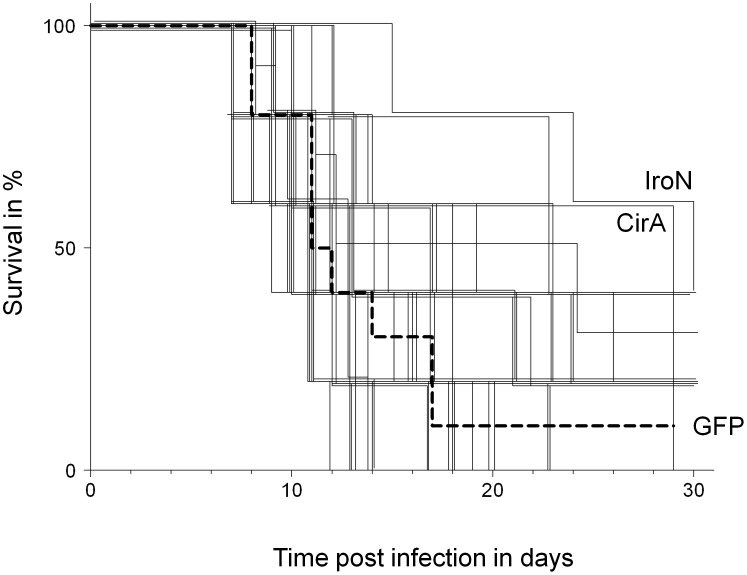
Survival curves of mouse groups immunized with 37 different Salmonella antigens (thin lines) or the control antigen GFP (thick dashed line).For better visualization, curves were slightly shifted. The longest survival was observed for antigens IroN and CirA. For statistical analysis by log-rank test see Table 1.